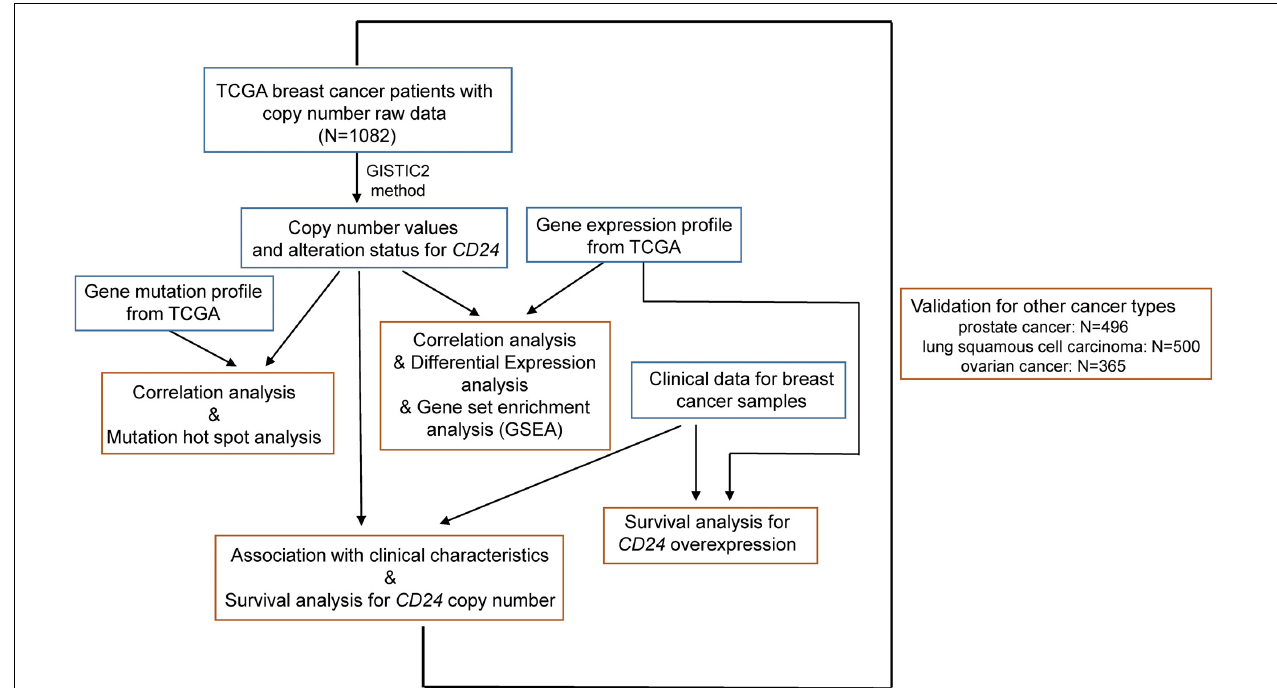
FIGURE 1 | Illustration of study workflow. The flowchart of data collection and method implementation in this work.